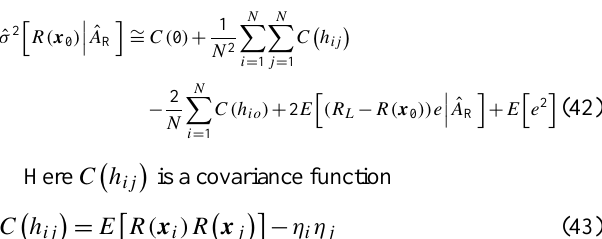
( ) h R γ (right), 10 minutes average. 4 L